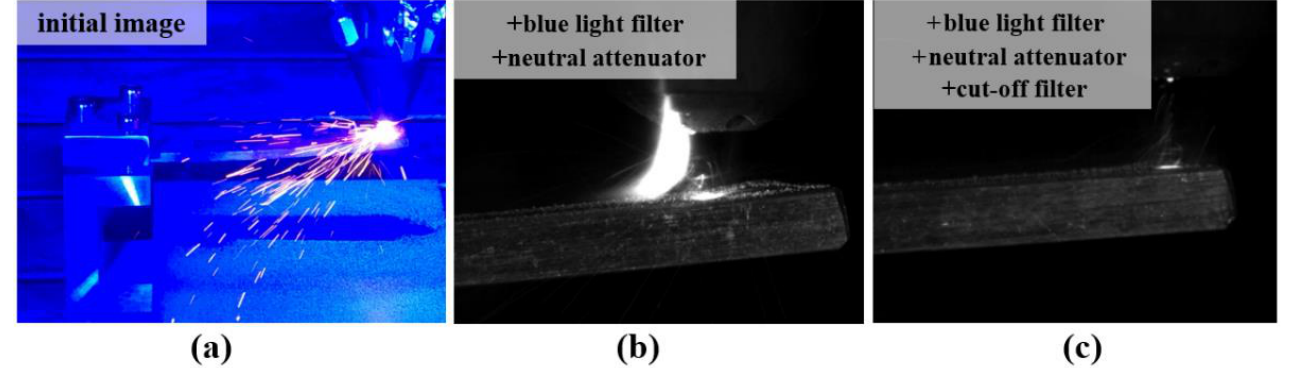
Figure 6. Effects of different filter combinations: ( a ) initial picture; ( b ) with attenuator and narrow- band filter; and ( c ) with attenuator, narrowband filter and 1064 nm cut-off filter.